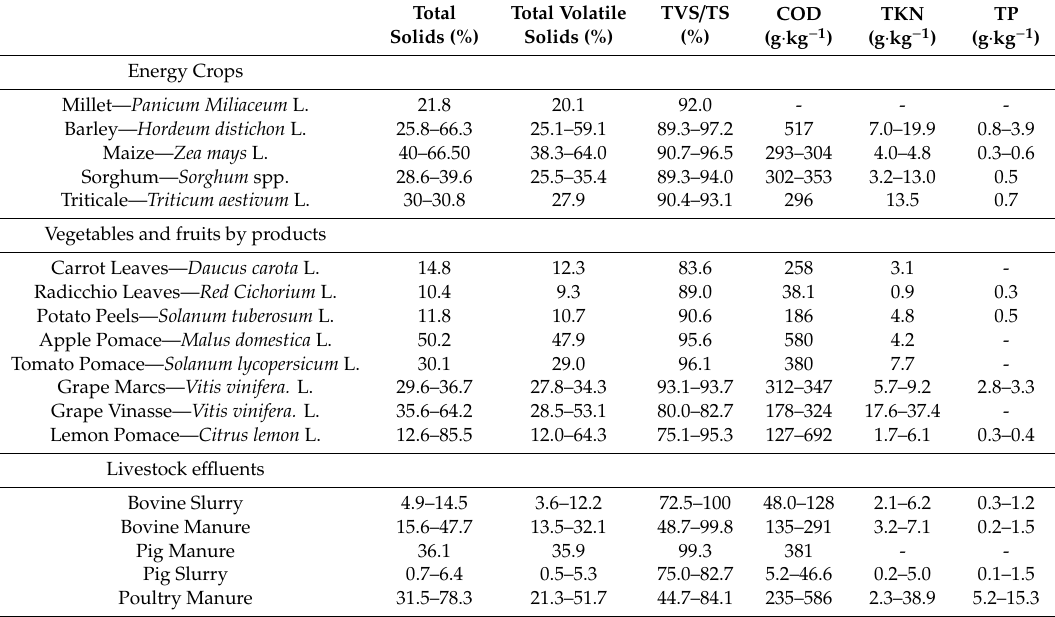
Table 3. Summary of chemical-physical characteristics of the organic biomass more abundant in the Italian context. Energy